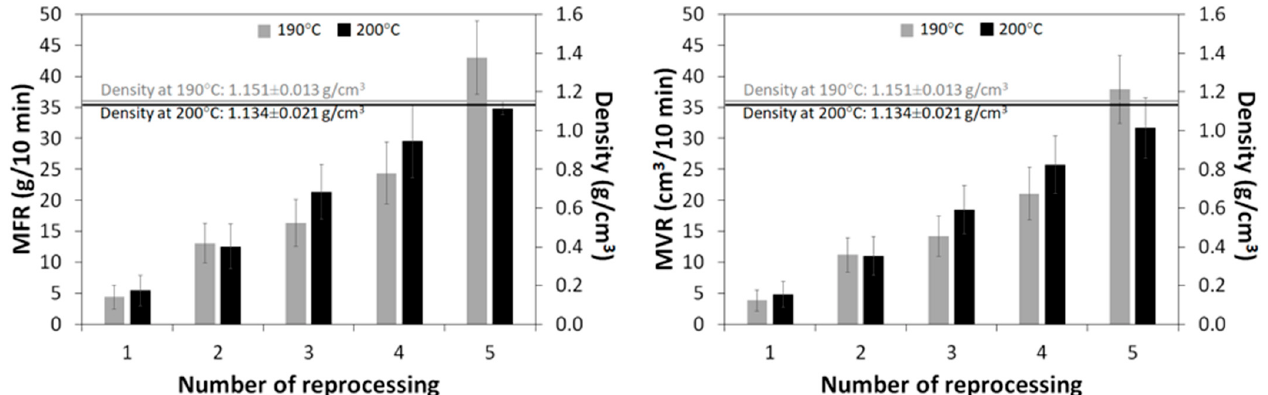
Figure 2. MFR, MVR and melt density of the conductive PLA 3D-printing filament as a function of reprocessing cycles.